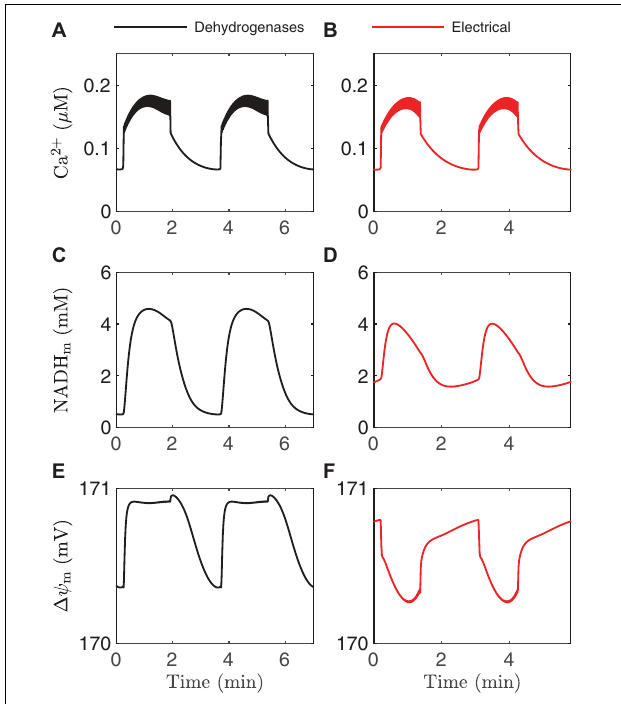
FIGURE 9 | Time courses generated by the IOM with p 21 = 0 . 013 µ M / ms (A,C,E) and 0 . 03 µ M / ms (B,D,F) . In both cases, v PDH = 0.4 µ M / ms, g K ( Ca ) = 150 pS, and the glucose concentration in 11 mM. In the left panel, the effect of Ca 2 + on dehydrogenases dominates, while on the right the electrical effect of Ca 2 + current across the inner membrane